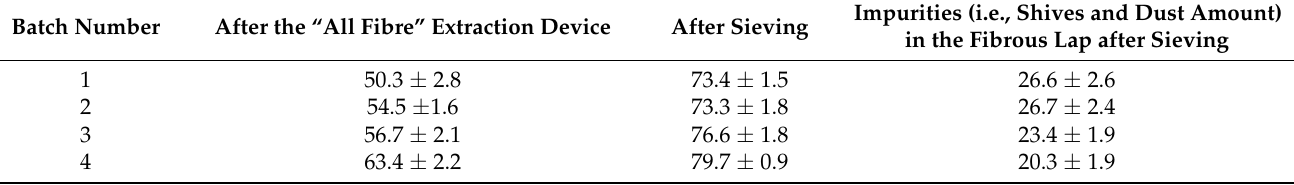
Table 6. Purity of the fibrous materials in fibres during process B (i.e., for the fibre lap at the outlet of the “all fibre” extraction device, and after sieving), and number of impurities in the fibrous lap after sieving (percentage in